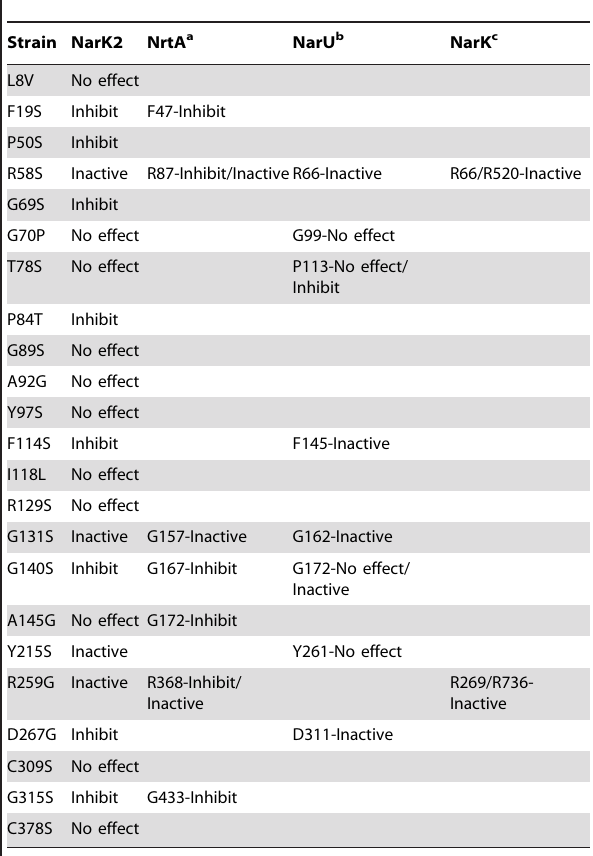
Table 3. Comparison of the Effect of Mutations in NarK2 to Mutations in the Comparable Amino Acids in Other Nitrate/ Nitrite